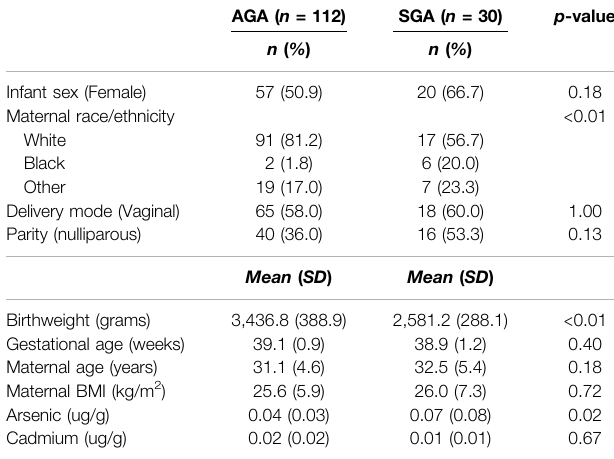
TABLE 1 | Study participant characteristics ( n =